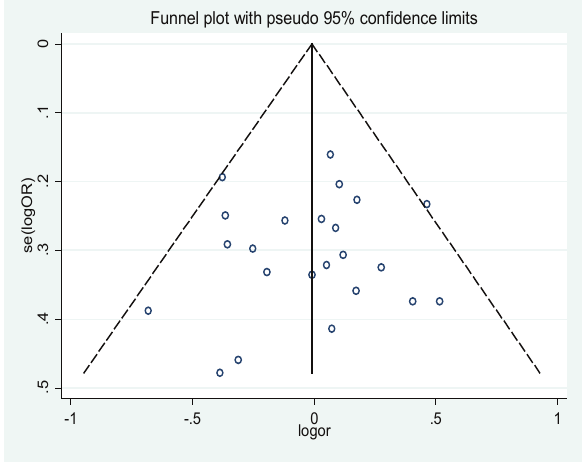
Figure 6: The Begg’s funnel plots showe no significant publication bias under recessive genetic model(GG vs AG+AA)